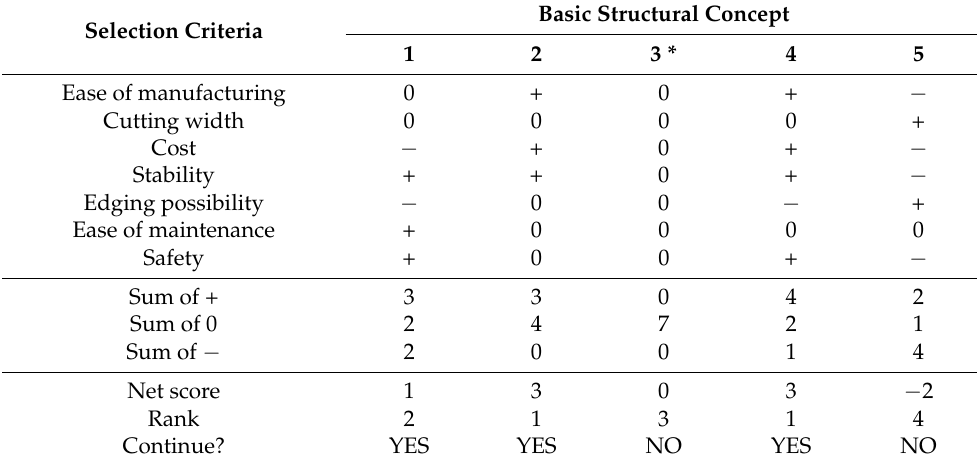
Table 4. Screening of basic structural concepts. Selection